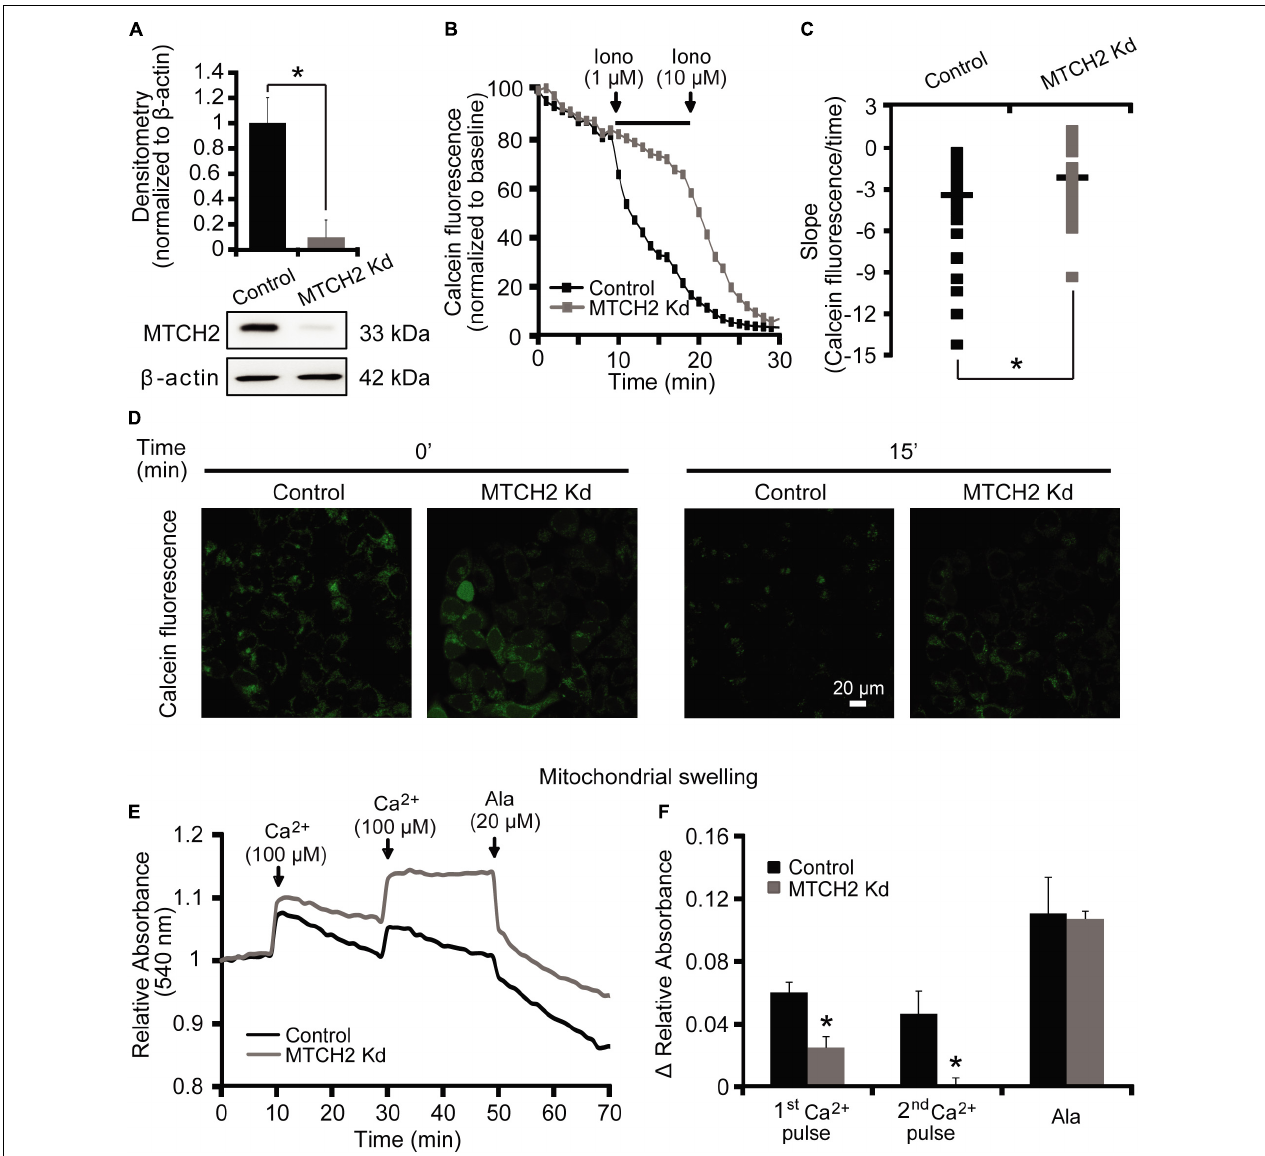
FIGURE 1 | MTCH2 modulates mPTP opening in HCT116 cells. (A) Bax/Bak double-deficient HCT116 cells were infected with a lentivirus shRNA vector against Mtch2 or scramble shRNA. Reduced protein levels of MTCH2 after shRNA expression compared to the scramble were assessed by quantitative Western blotting 72 h post-transduction. Probing for β -actin served as loading control. Experiments were repeated three times with similar results. Densitometric data are normalized to β -actin. Means ± SEM are shown. * p ≤ 0.05 compared to Bax/Bak double-deficient control HCT116 cells (ANOVA, post hoc Tukey). (B–D) Cobalt-quenching assay was performed in Bax/Bak double-deficient MTCH2 kd and control HCT116 cells. Mitochondrial calcein leakage was analyzed after sequential addition of ionomycin (1 and 10 µ M) and representative traces are shown (B) . Quantification of the slope (the change in FRET/CFP ratio over time in minutes) between 10 and 20 min time point (corresponding to the two additions of ionomycin) is illustrated (C) . Representative images of calcein-CoCl 2 staining of Bax/Bak double-deficient MTCH2 kd and control HCT116 cells before ( t = 0 min) and after the first addition of ionomycin ( t = 15 min) are shown (D) . Scale bar = 20 µ M. A minimum of 40 cells from at least n = 3 independent experiments were analyzed per cell type/condition. * p ≤ 0.05 compared to Bax/Bak double-deficient control HCT116 cells (ANOVA, post hoc Tukey). (E,F) Mitochondria isolated from Bax/Bak double-deficient MTCH2 kd and control HCT116 cells as described in the section “Materials and Methods,” were pre-incubated at 30 ◦ C in experimental buffer in a 96-well plate at a final volume of 100 µ l per well. Absorbance at 540 nm was detected at 30 s intervals and CaCl